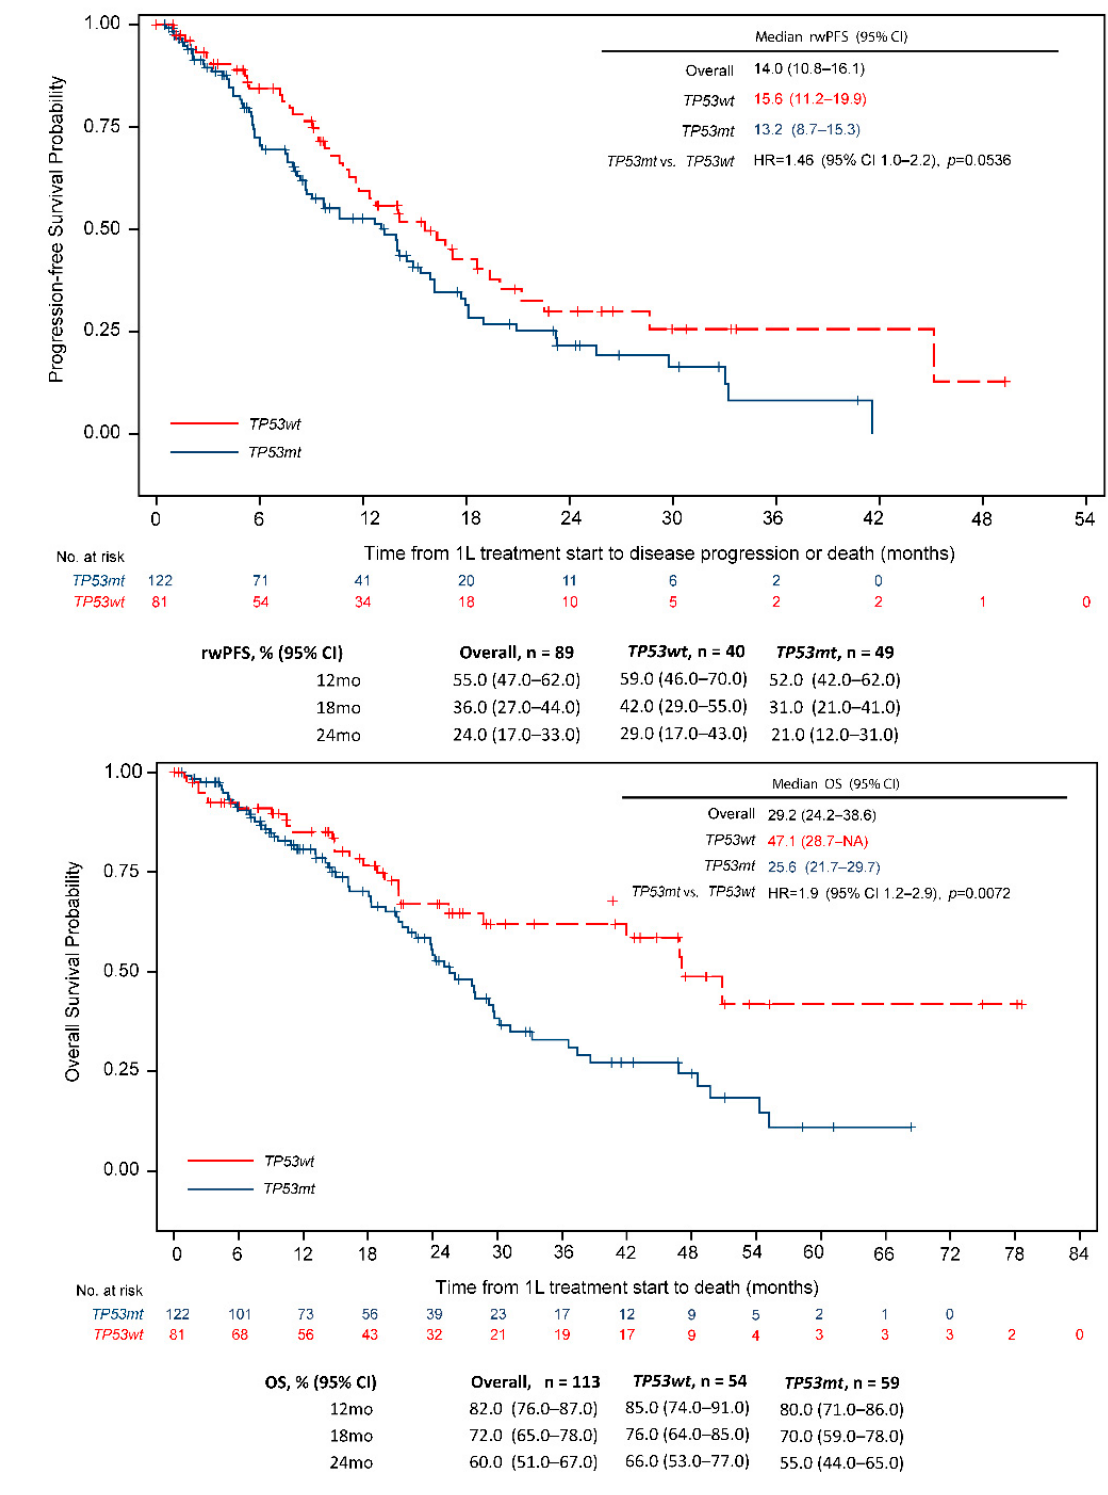
Figure 3. rwPFS and OS— TP53 co-mutation vs. TP53 wild-type by Exon19del mutation. ( A ) rwPFS. ( B ) OS. Unadjusted HR and 95% CI. CI = confidence interval; HR = hazard ratio; OS = overall survival; rwPFS = real-world progression-free survival; TP53mt = TP53 co-mutation; TP53wt = TP53 wild-type; exon 19 = exon 19 deletions.